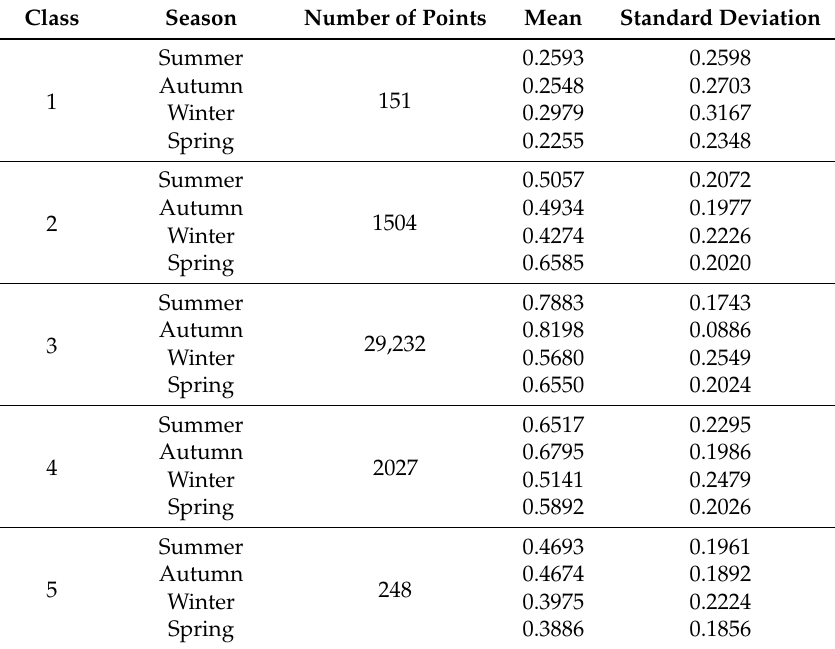
Table 4. Frequency distribution of NDVI values of individual land cover